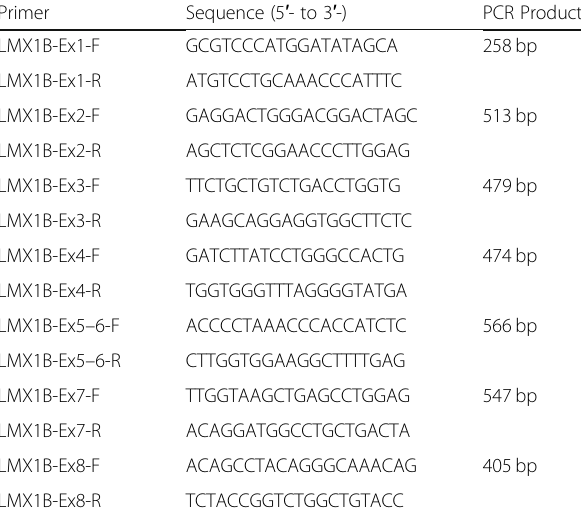
Table 1 The primers for amplifying LMX1B